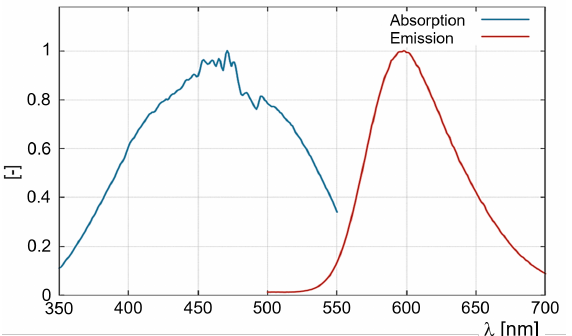
Figure 1. Emission and excitation spectra of Ru(phen) embedded in the nylon matrix which was dissolved in ethanol to be spayed on a sample by spray